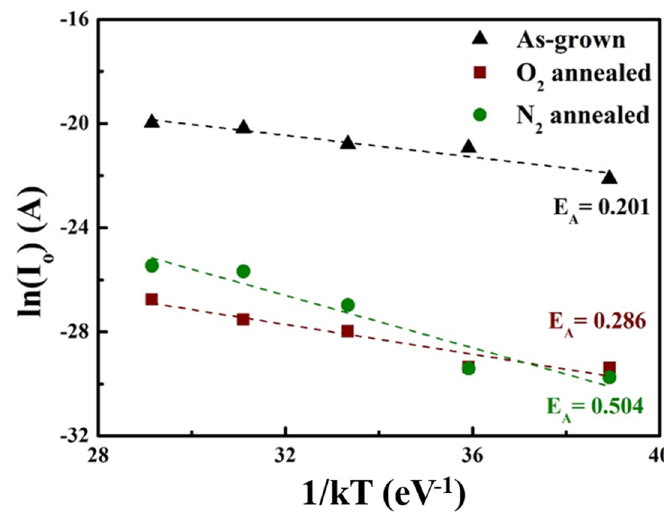
Figure 7. ln(I O )–1 / kT curve for activation energy values derived from the increasing temperature.